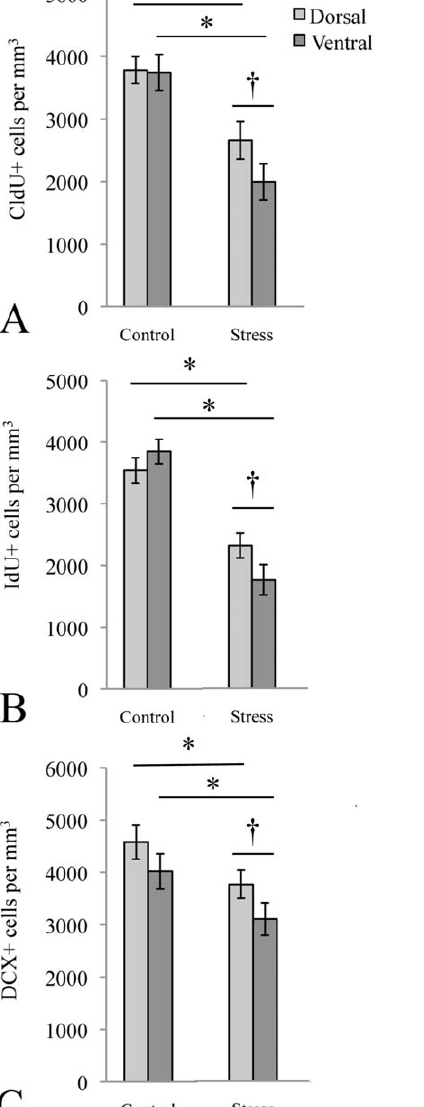
Figure 3. Stress most severely affected neurogenesis in the ventral dentate gyrus. Compared with controls, rats in the CUS group showed decreased proliferation (A), survival (B) and neuronal differentiation (C) in the dentate gyrus. This effect was most pro- nounced in the ventral, compared to the dorsal, sub-region ( { indicates significant difference between subregions). * significantly different from control.